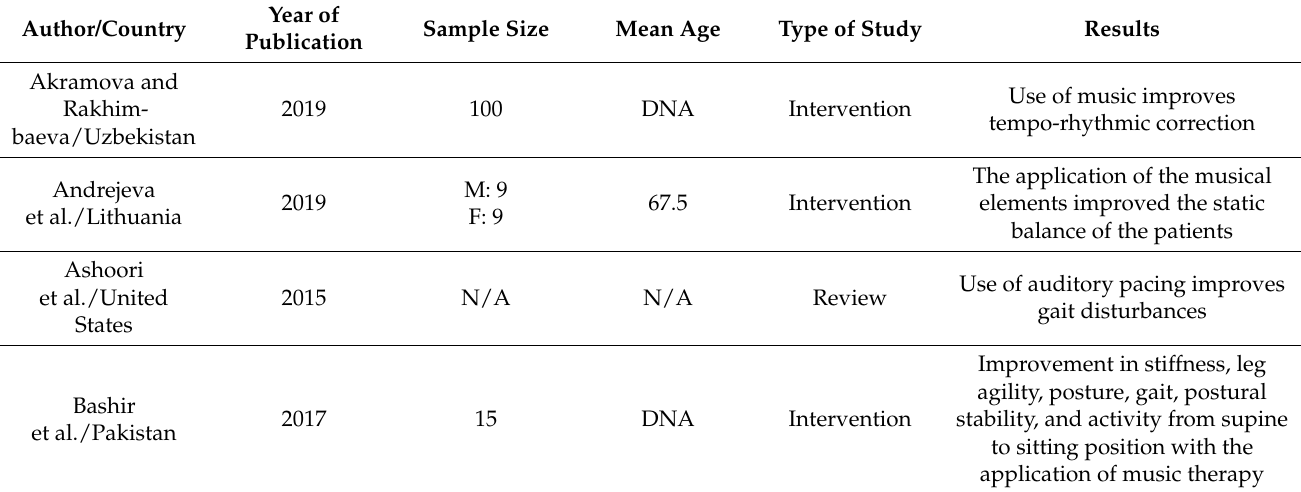
Table 4. Articles that address the effects of music therapy on motor